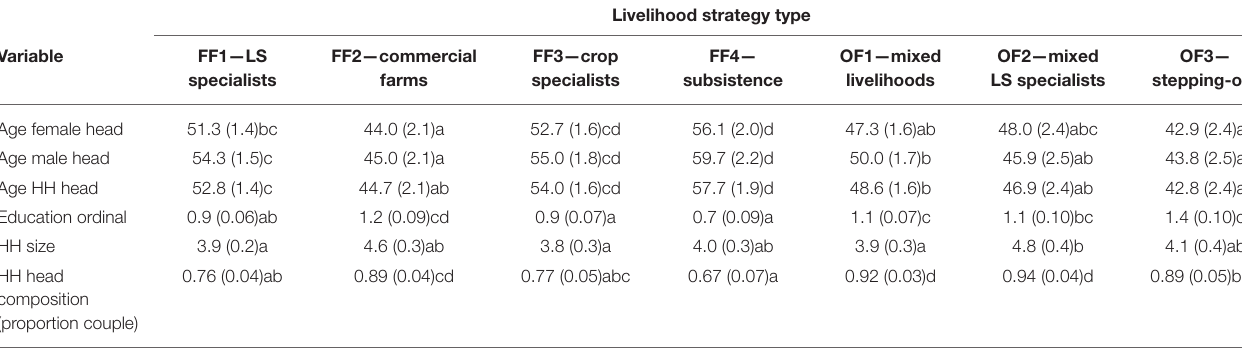
TABLE 5 | Estimated marginal means for household characteristics of the different household livelihood strategy types # .